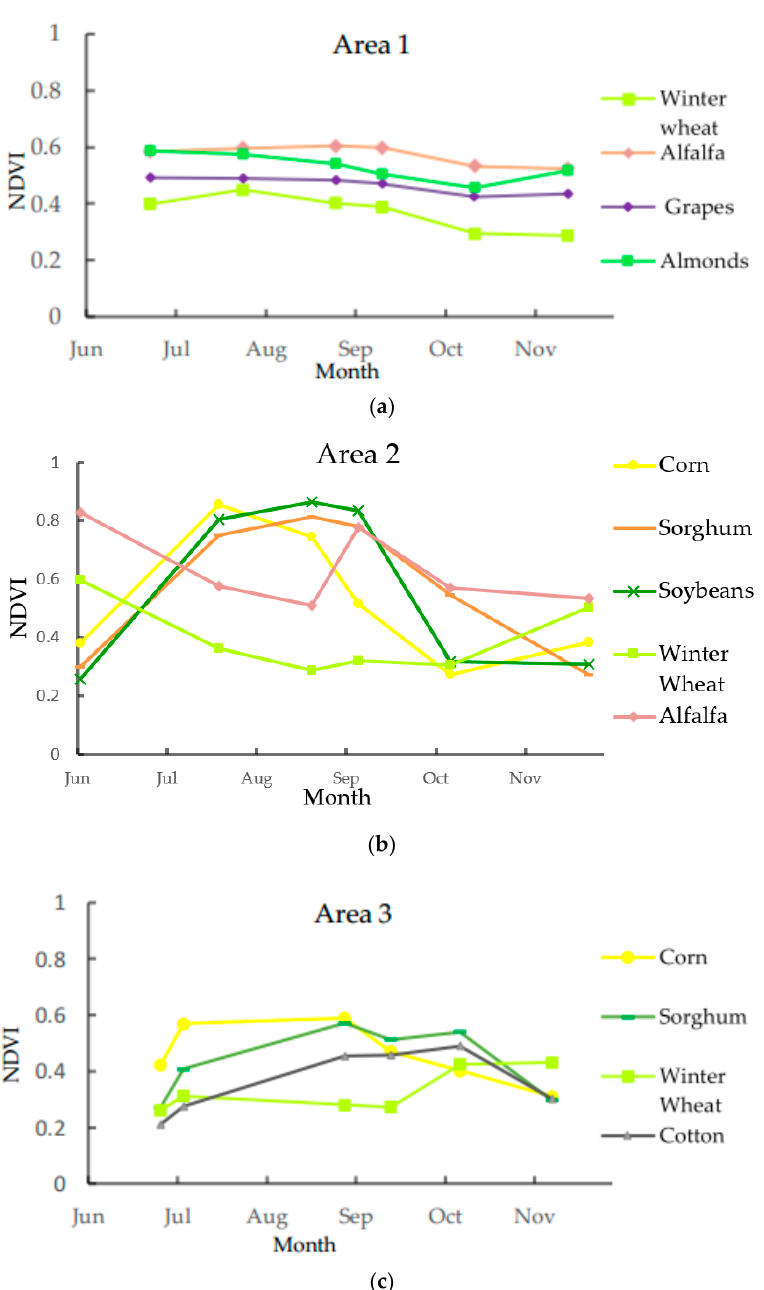
Figure 3. The normalized difference vegetation index (NDVI) curves of crops grown in ( a ) study area 1, ( b ) study area 2, and ( c ) study area 3.